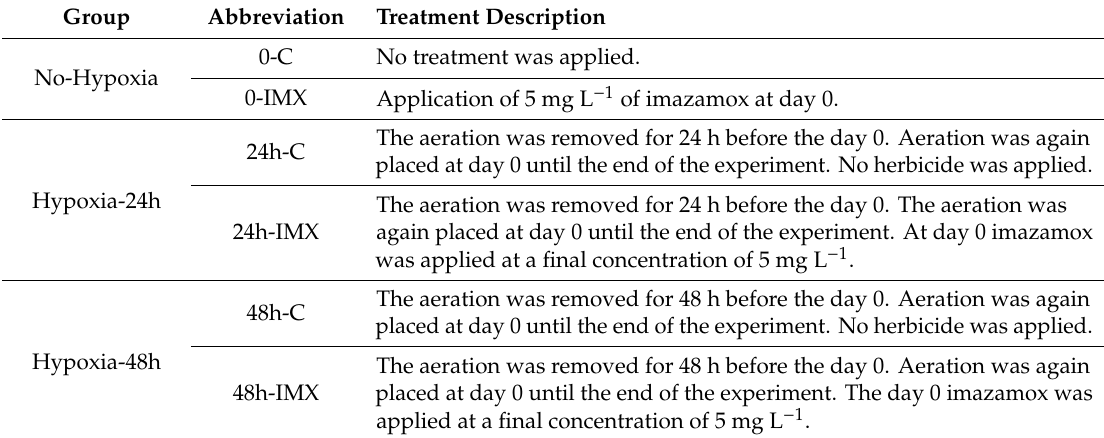
Table 1. Summary of the treatments.